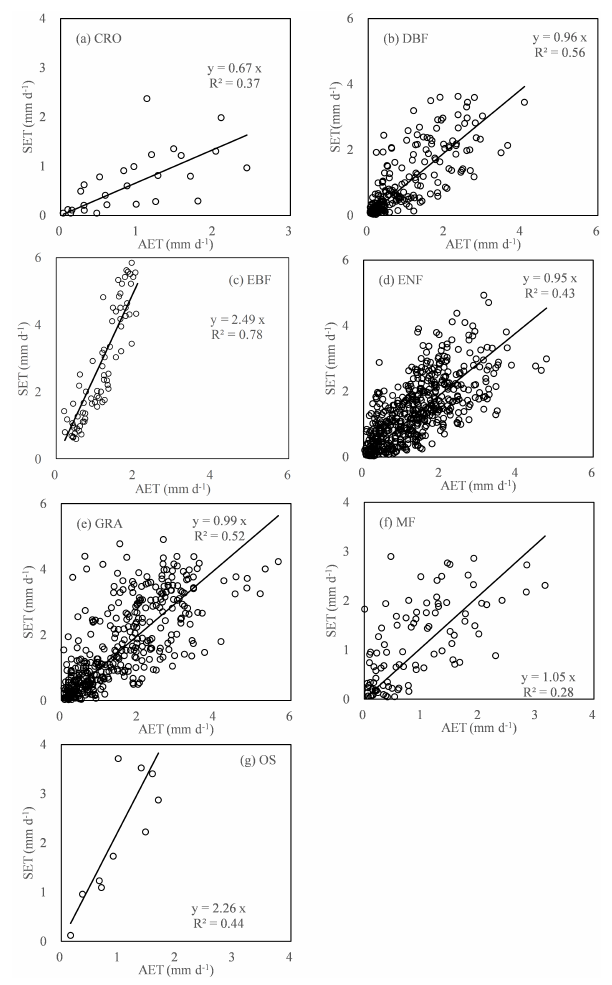
Figure 8. Relationships between the simulated ET using K c from Table 1 (SET) and the measured ET (AET) for different vegetation surfaces. Panels (a–f) stand for cropland (CRO), deciduous broad leaf forest (DBF), evergreen broad leaf forest (EBF), evergreen nee- dle leaf forest (ENF), grassland (GRA), mixed forest (MF), and open shrubland (OS). All the determination coefficients ( R 2 ) listed in the figure were significant ( p